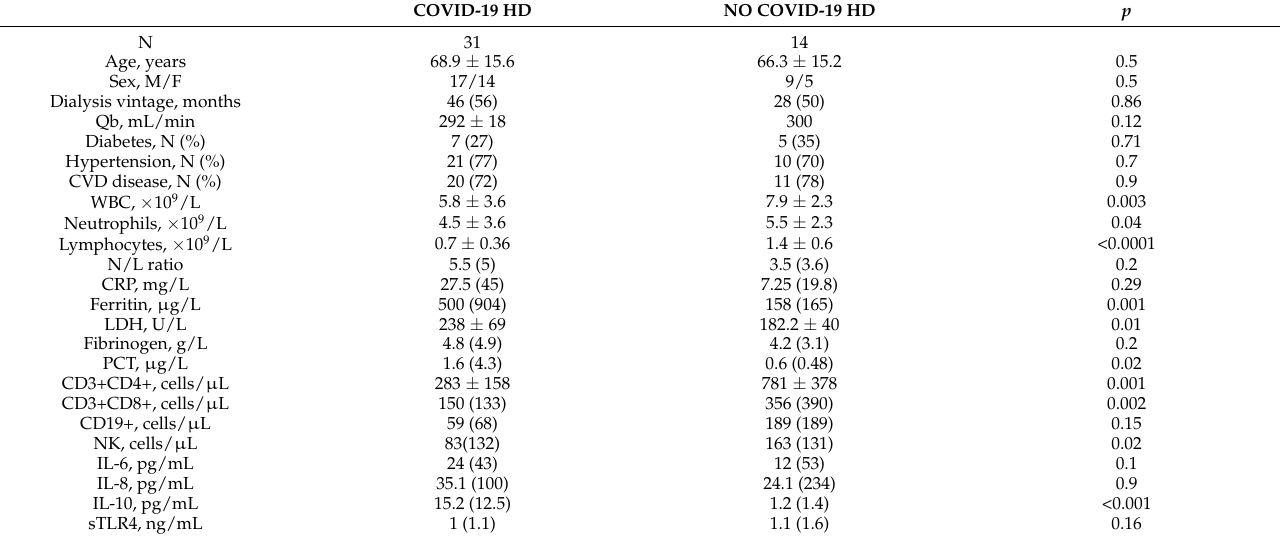
Data are expressed as mean ± SD or median (IQR). All values were determined in predialysis. Abbreviations: White blood cells (WBC), neutrophil/lymphocyte (N/L), C-reactive protein (CRP), lactate dehydrogenase (LDH), procalcitonin (PCT), neutrophil/lymphocyte ratio (N/L)., interleukin-6 (IL-6), interleukin-8 (IL-8), interleukin-10 (IL-10), soluble TLR4